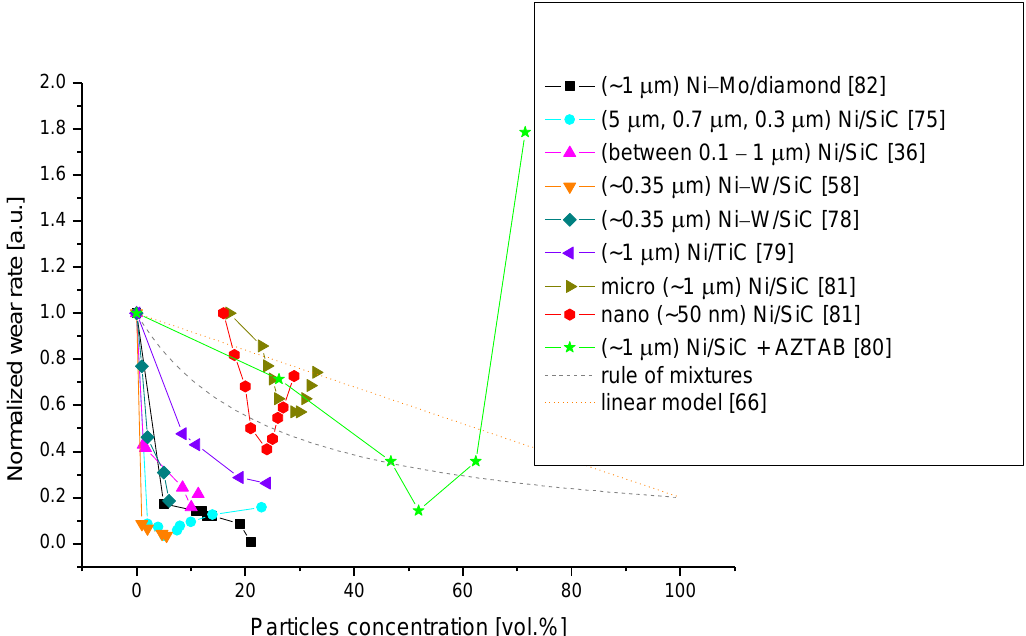
Figure 3. Normalized wear rate vs. particle concentration (vol.%) with indicated theoretical curves for the rule of mixtures and a linear model. The coefficients of friction (CoFs) graph includes friction measurements at room temperature for metal matrix composites (MMCs) without annealing.